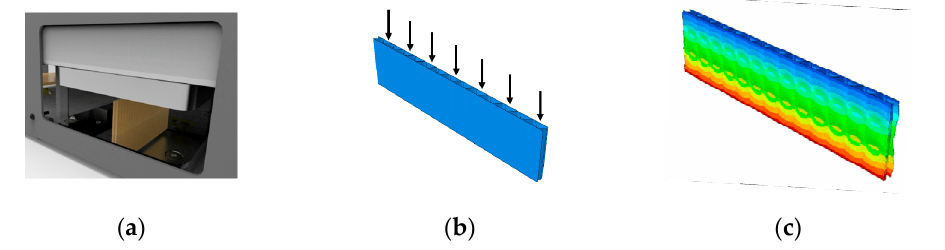
Figure 2. The edge crush test: ( a ) corrugated board testing device; ( b ) loaded sample; ( c ) deformed sample.